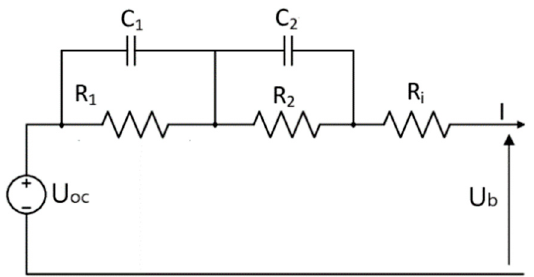
Figure 1. Equivalent Circuit Model of the battery. R i —internal battery resistance [ Ω ]; R 1 —SEI layer resistance [ Ω ]; C 1 —SEI layer capacity [F]; R 2 —battery element resistance [ Ω ]; C 2 —internal battery capacity [F]; Uoc— battery open circuit voltage [V].